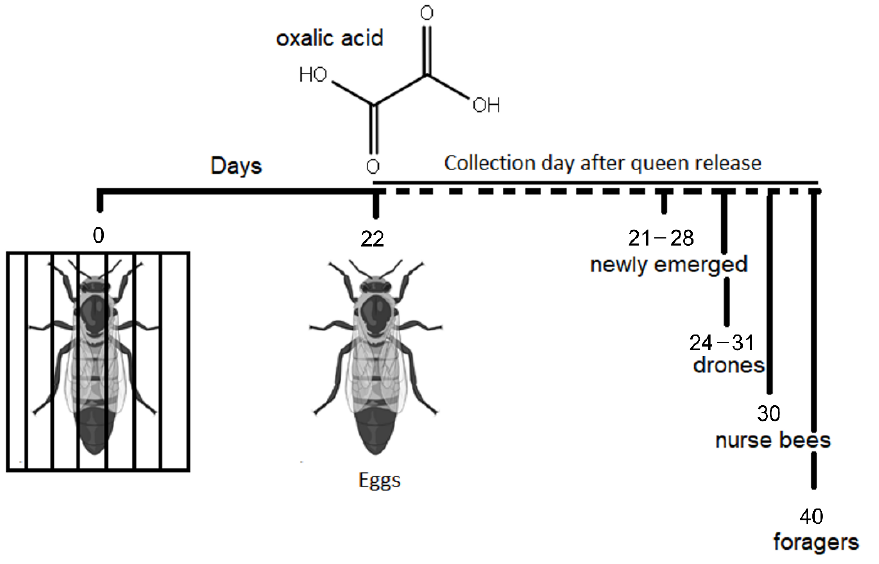
Figure 1. Experimental design for sample collection. Figure created with Biorender.com, accessed on 17 March 2022.